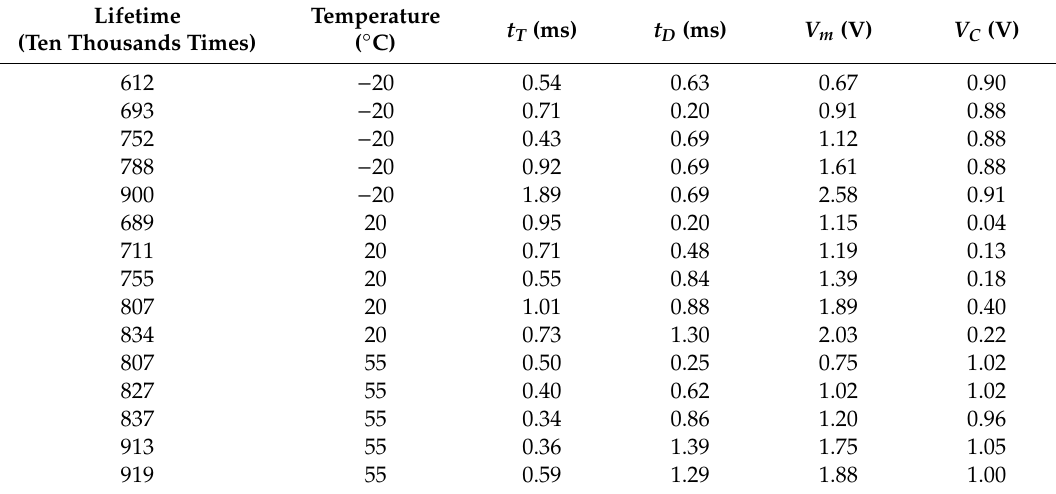
Table 8. The initial performance parameters of relay and its